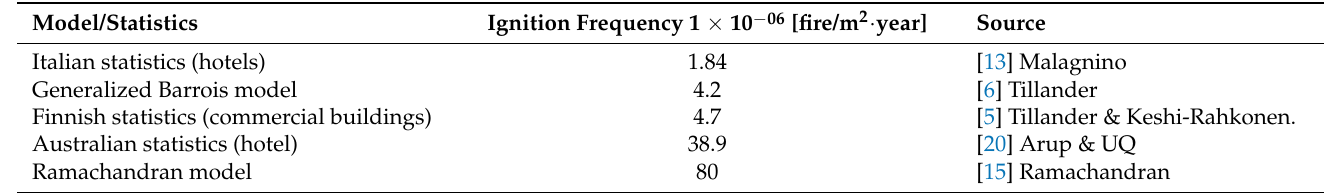
Table 7. Hotel average ignition frequency according to different models or